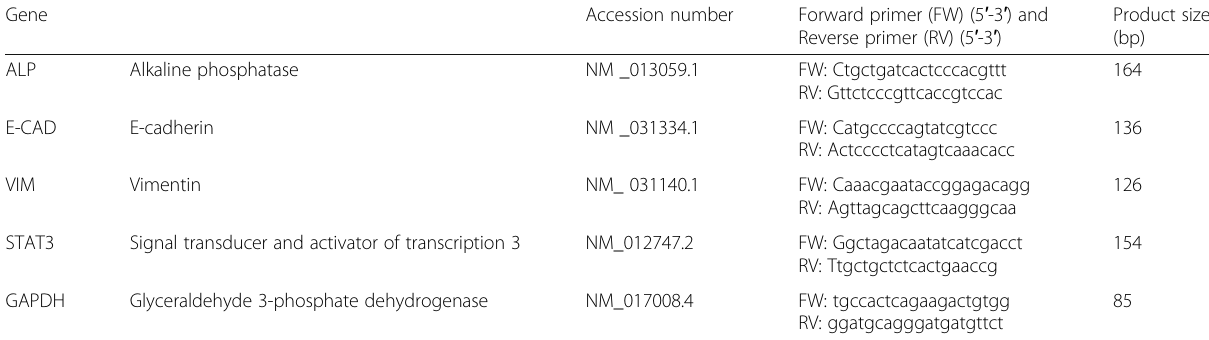
Table 1 The primer sequences, Alp, E-Cad, Vim, STAT3, and gapdh were purchased from the manufacturer Eurofins Genomics Gene